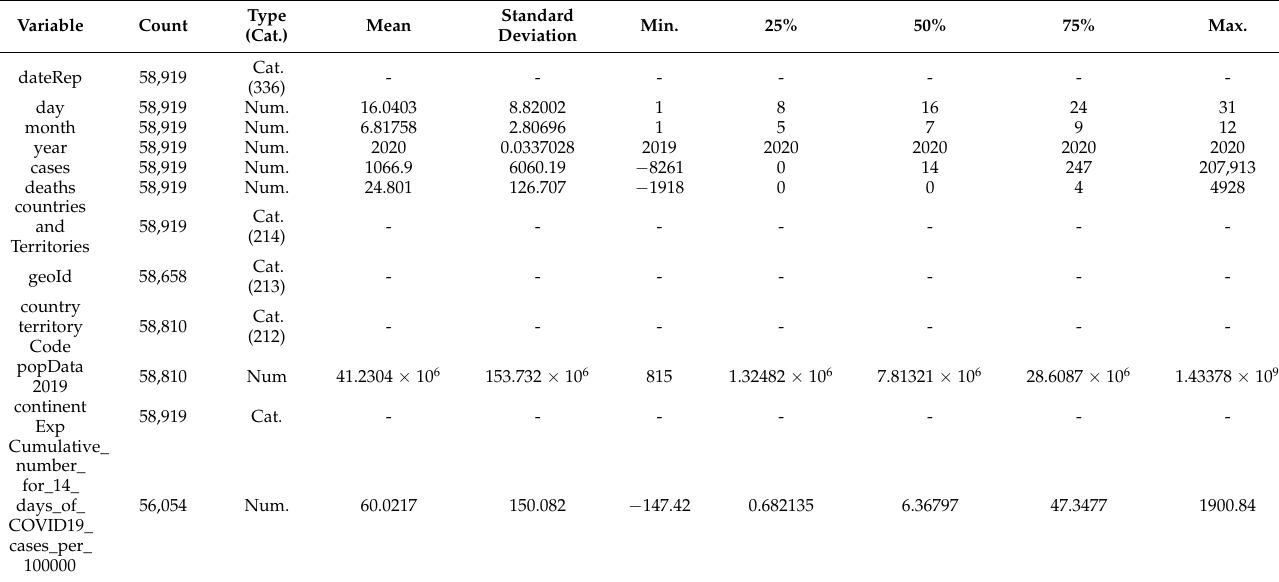
Table 2. ECDC Dataset [20] Summary Statistics.